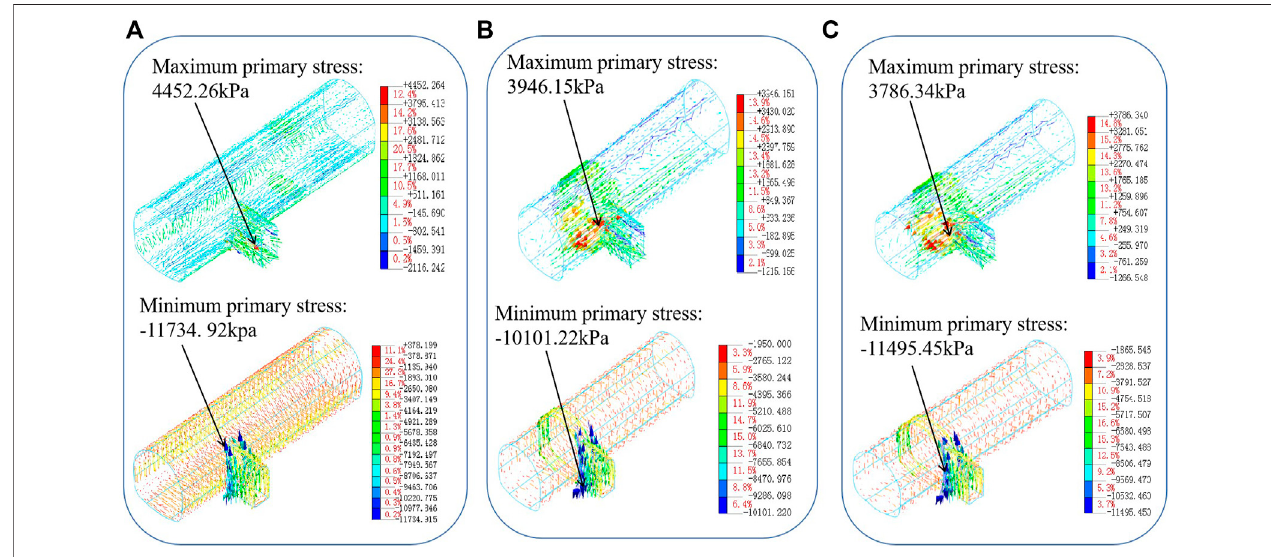
FIGURE5| Primarystressofsupportingstructure undereach method (unit: kPa) (A) Thedouble-holes intervalpillar, (B) thesector expansionmethod,and (C) the gate climbing method.